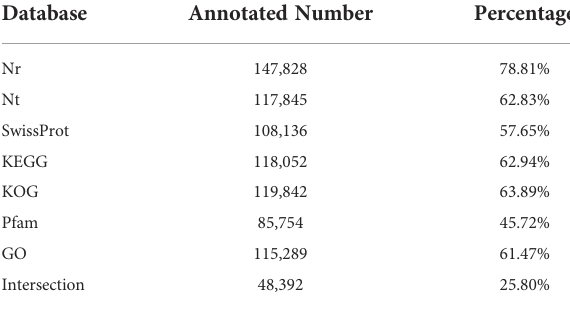
TABLE 1 Information of function annotation.